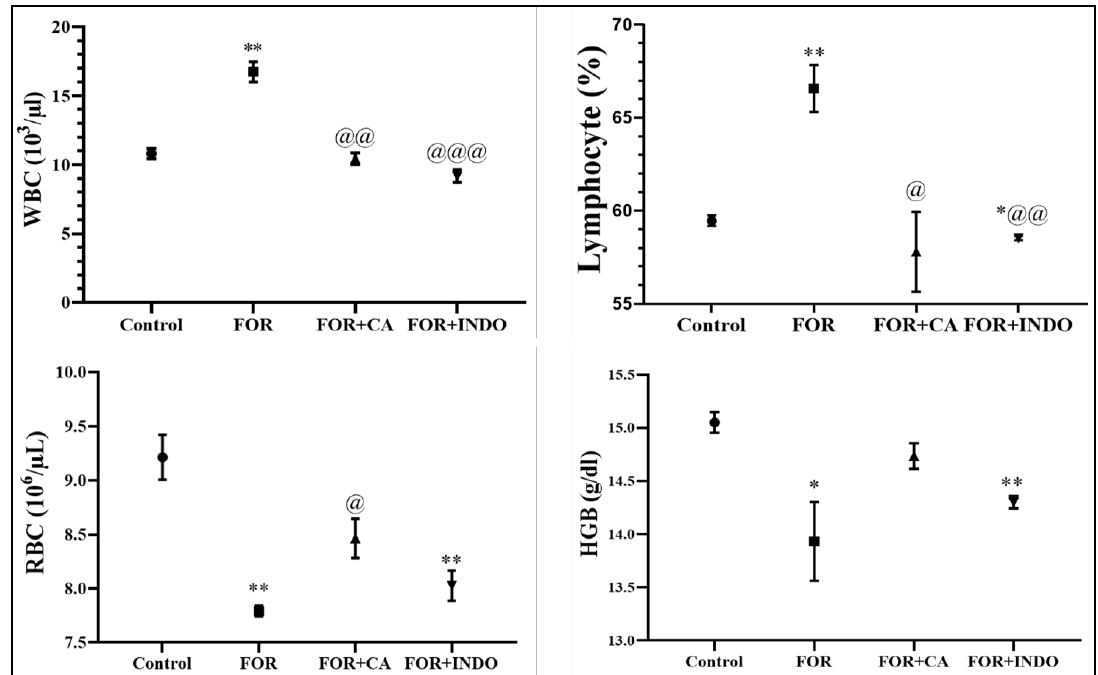
Figure 2. Hemogram parameters of experimental groups. * p < 0.05, ** p < 0.01 vs. control group; @ p < 0.05, @@ p <0.01, @@@ p < 0.001 vs. FOR group.